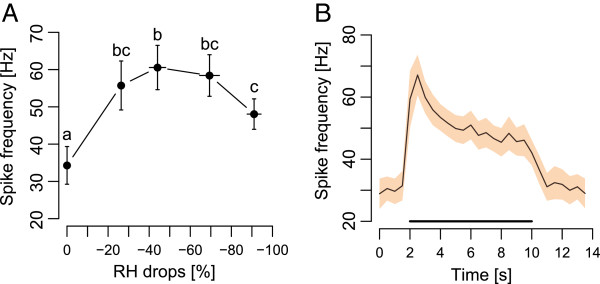
Neuronal responses in G. pallidipes palp basiconic sensilla to RH decreases in the air. A Mean neuronal responses (± SEM) recorded from 17 basiconic sensilla on 1 female and 4 male G. pallidipes to RH decreases (from 100%). Spike frequencies with different letters are significantly different. B Mean responses of neurones in the same 17 sensilla (± SEM, shaded area) to a RH decrease of −44.1% for 8 s (bold black bar). The spike frequency is the integration of the number of spike over 500 ms bins.